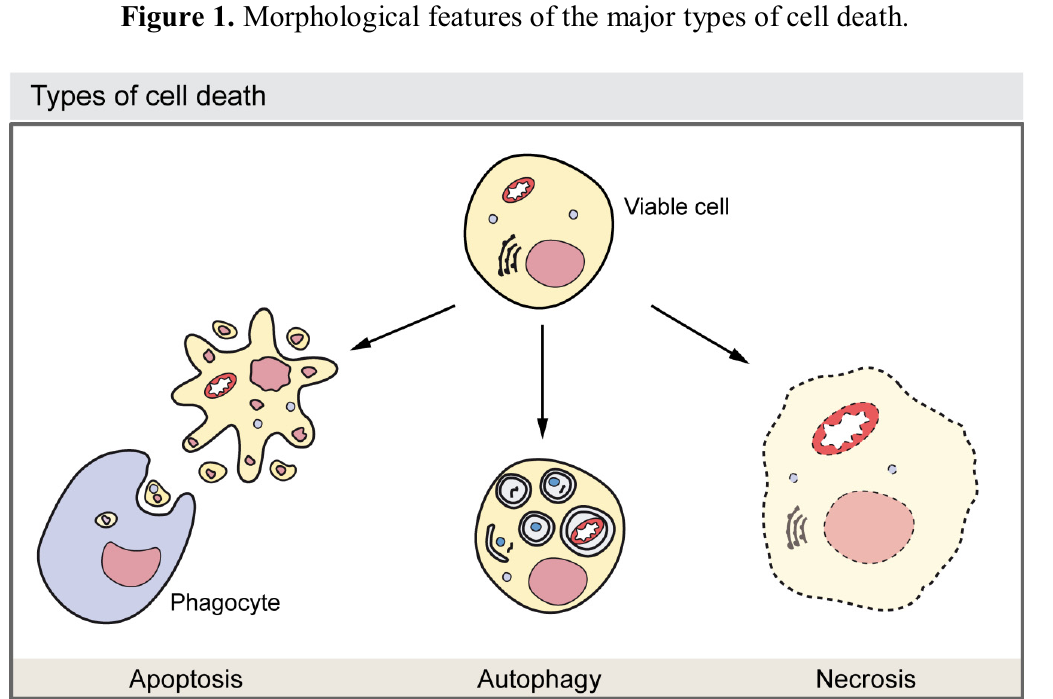
Figure 1. Morphological features of the major types of cell